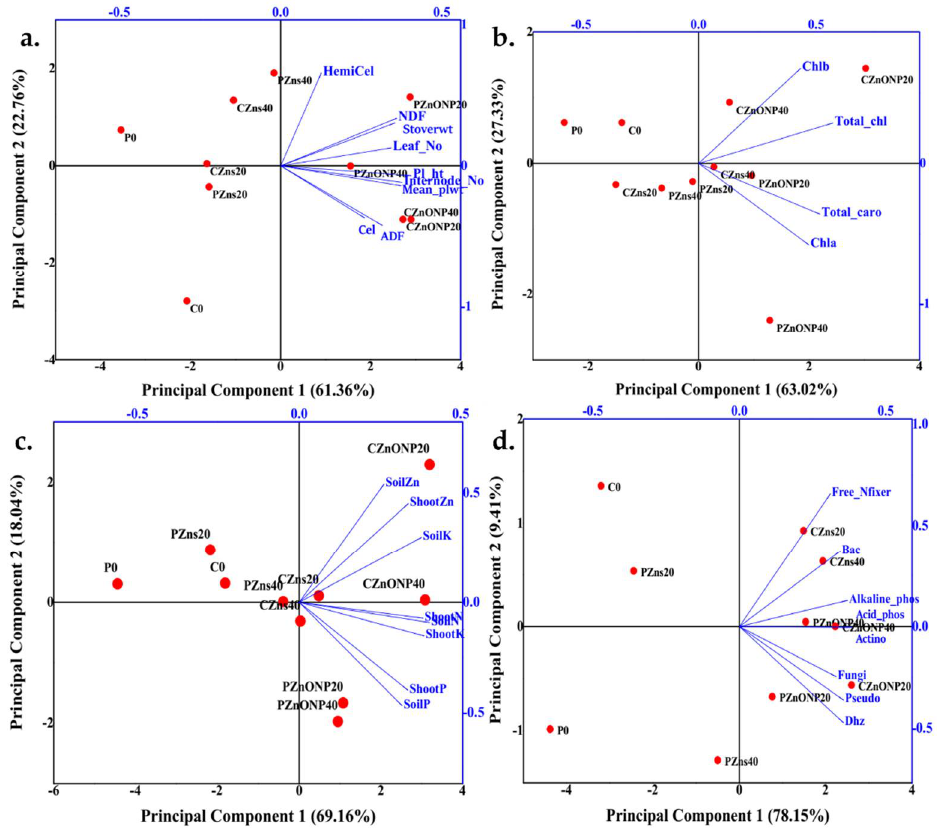
Figure 4. Principal component analysis of the maize vegetative and photosynthetic attributes, yield, nutrient status and soil microbiological parameters. ( a ) Vegetative and yield attributing traits, ( b ) photosynthetic pigments, ( c ) soil and plant shoot nutrient status, and ( d ) soil microbial viable counts and soil enzymatic characters.